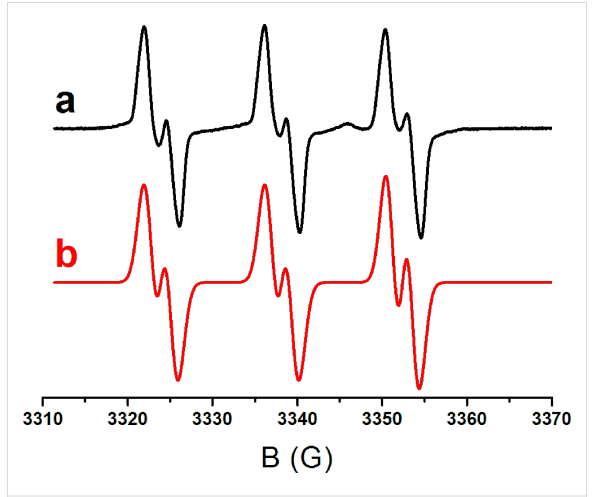
Figure 9: ESR spin-trapping spectra for the irradiation of a Ir(piq) 2 (tmd)/Ph 2 I + solution in the presence of PBN; green LED bulb at 514 nm irradiation (the phenyl radical adducts are characterized by a N = 14.2 G, a H = 2.2 G, in full agreement with previous data) [45-52].